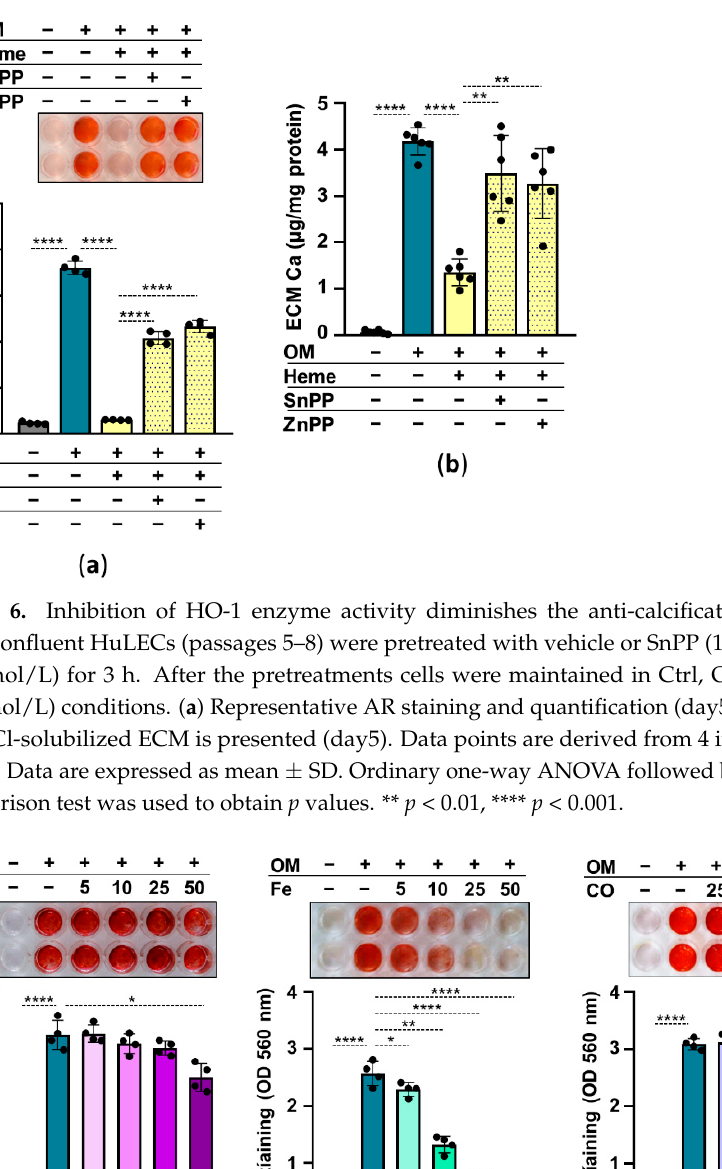
7 of 14 Figure 5. Inhibition of Nrf2 diminishes the anti-calcification effect of heme. ( a , b ) Confluent HuLECs